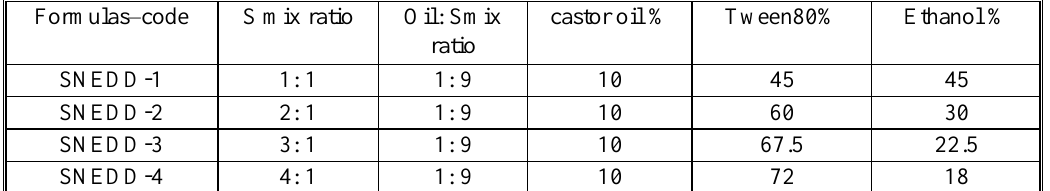
Table 1.Composition of bromocriptine mesylate liquid self-nanoemulsifying drug delivery systems (%